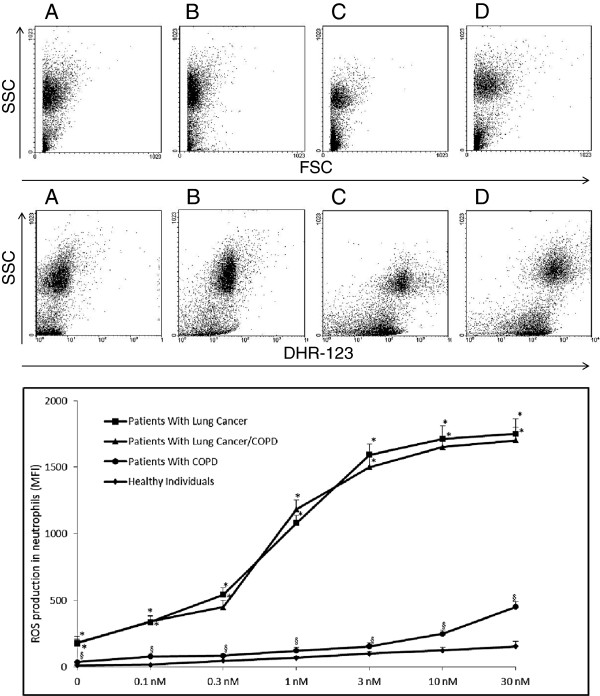
A histogram representing changes in ROS production in the neutrophils of peripheral blood of study patients after stimulation with different concentrations of PMA. Data are presented as mean fluorescence intensity (MFI) ± SEM. *P < 0.05, when compared with COPD and healthy individuals groups; §P < 0.05, when compared with healthy individuals. The representative dot plot of neurophil population isolated from peripheral blood of healthy individuals (A), patients with COPD (B), patients with lung cancer/COPD (C) and patients with lung cancer (D) stimulated upon 30 nM of Phorbol 12-myristate 13-acetate (PMA). Side light scater (SSC) represents the granularity, complexity of the cells; FSC – forward light scatter (FSC) represents cell size; dihydrorhodamine-123 (DHR-123) a green fluorescent compound showing H2O2 intensity in neutrophils.